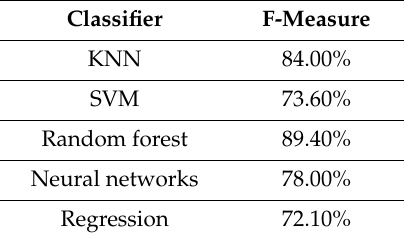
Table 5. F-measure results of the di ff erent classifiers at stage